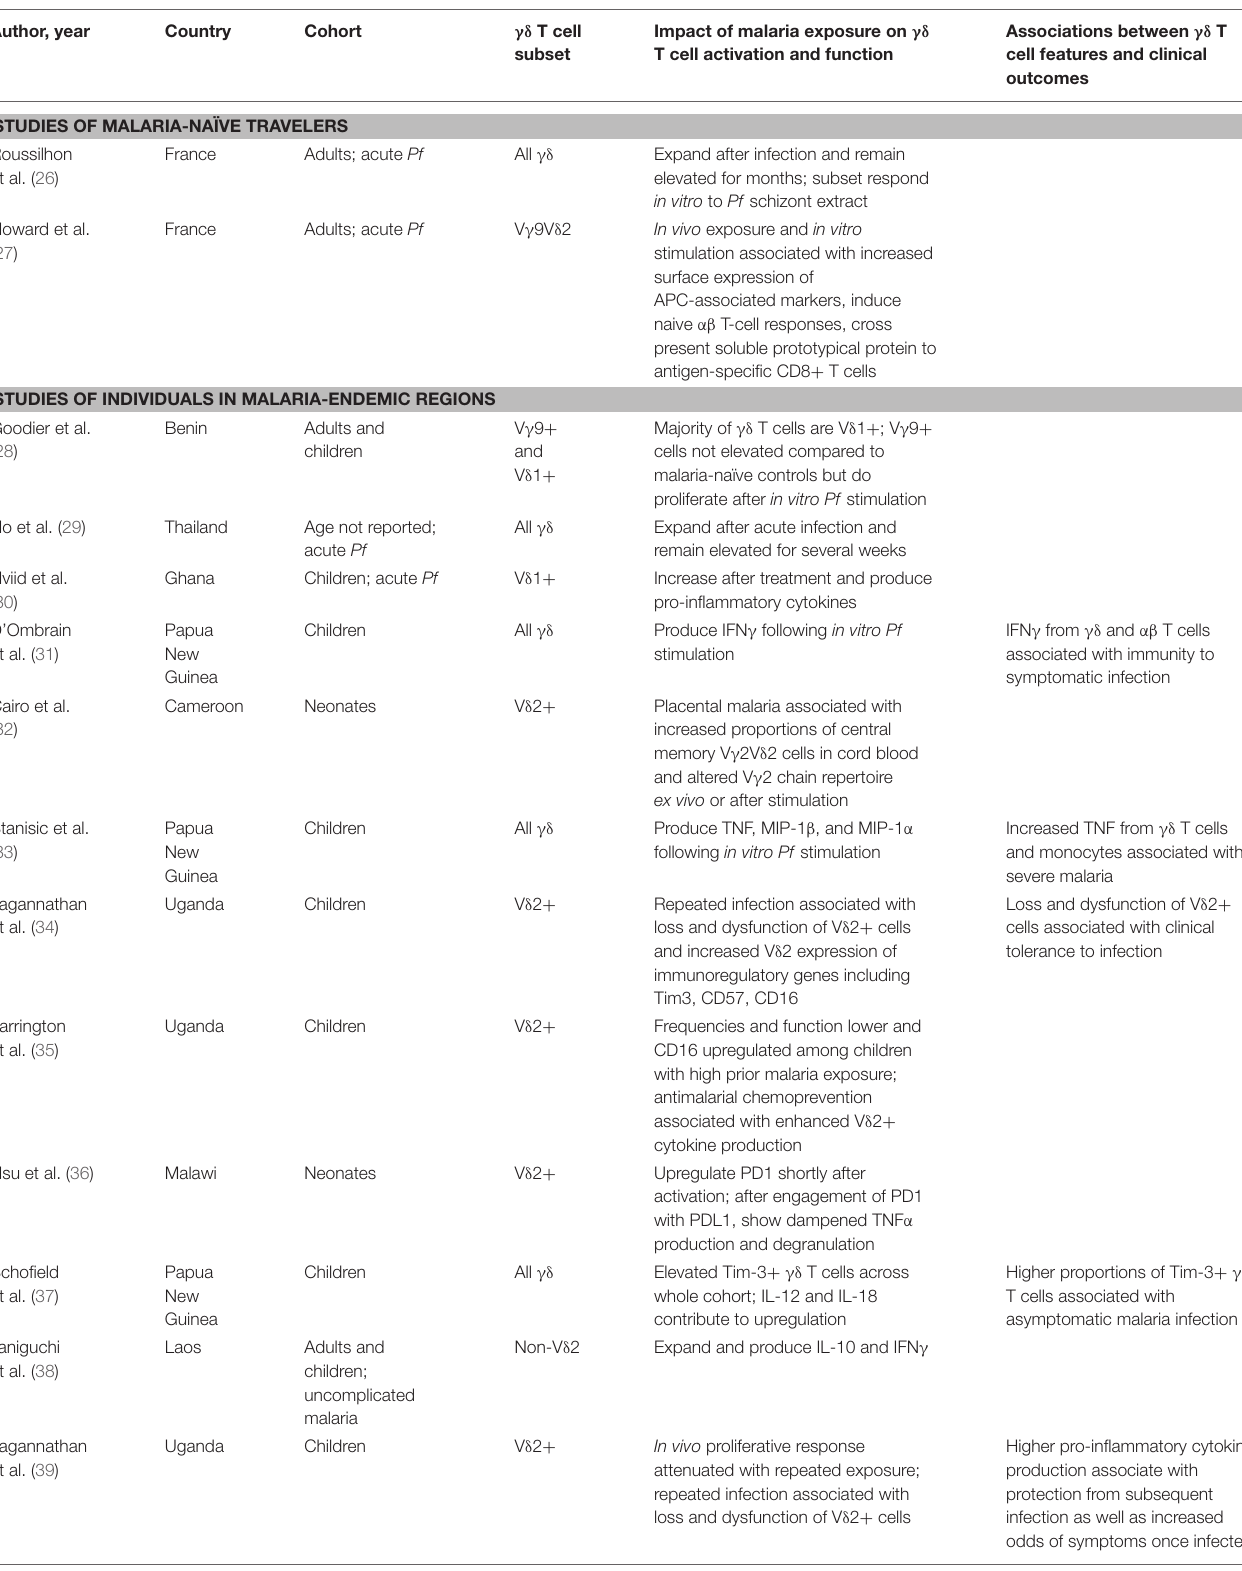
TABLE 1 | γδ T cell responses to human malaria and associations with clinical